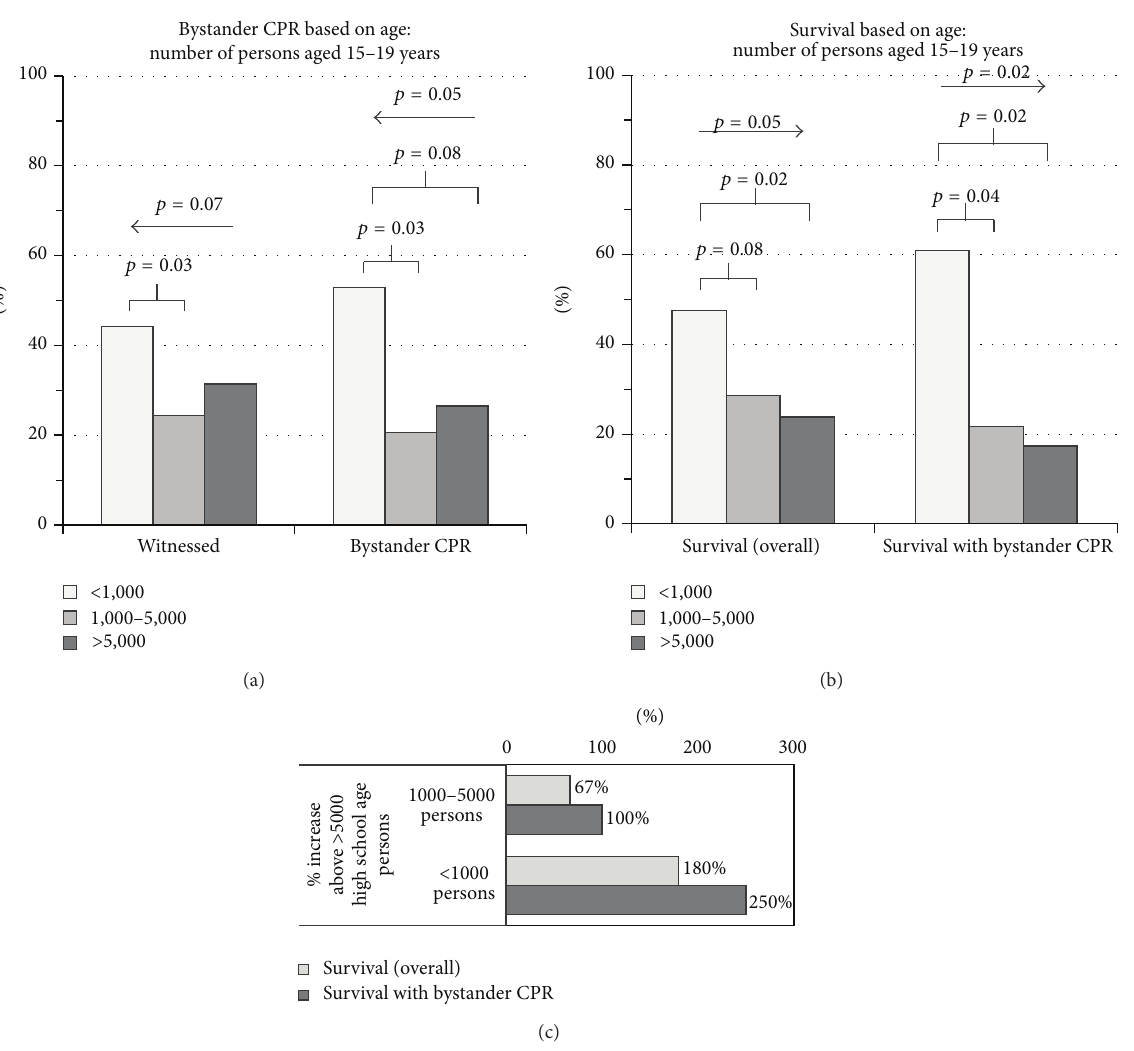
Figure 4: Bystander CPR based on number of high school age persons. (a) Neighborhoods were separated by number of high school age persons. Percentages of witnessed cardiopulmonary arrests (left) and bystander CPR (right) are displayed. (b) Overall survival (left) and survival with bystander CPR (right) are displayed. 𝑝 values with arrows indicate trends across the 3 groups. 𝑝 values with underlying brackets indicatedifferencesbetweenthetwopopulationsundereacharmofthebracket.(c)Percentincreasedsurvivalinlownumberandintermediate number of high school age persons versus high number of high school age